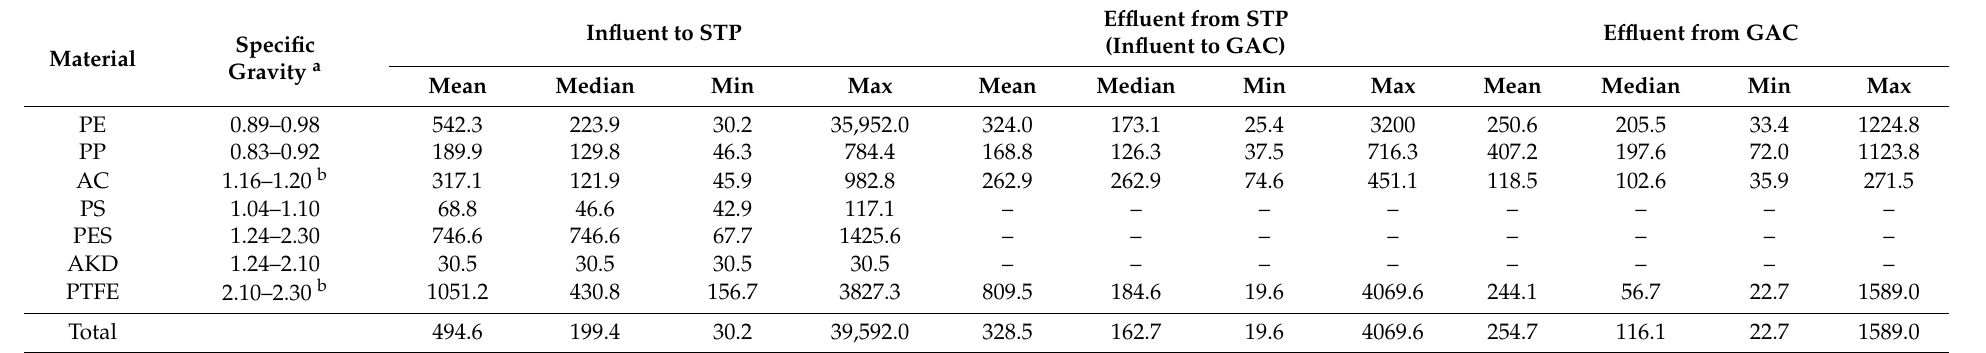
Table 1. Summary statistics of microplastic sizes at different treatment